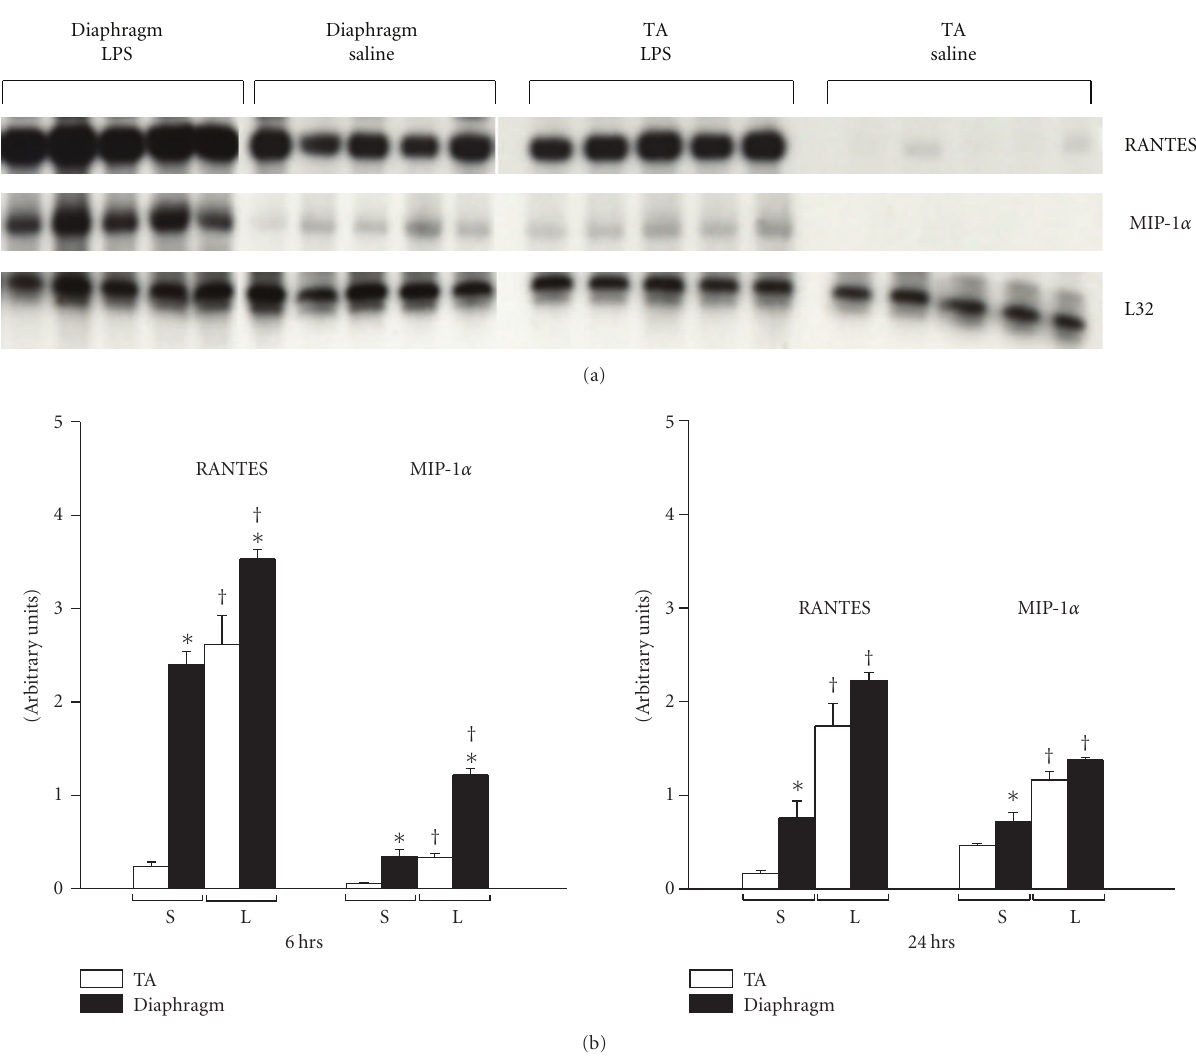
Figure 2: E ff ects of endotoxemia on RANTES and MIP-1 α gene expression in the diaphragm and limb muscle. (a) Ribonuclease protection assay demonstrating RANTES and MIP-1 α gene expression in the diaphragm and TA at 24 hours following LPS or saline administration. (b) Quantification of RANTES and MIP-1 α mRNA levels at di ff erent time points after LPS delivery. All data are group means ± SE, n = 6 mice per group. Data are normalized to the L32 housekeeping gene. ∗ P < . 05 for comparisons between diaphragm and TA within the same condition (LPS or sham control); † P < . 05 for comparisons between LPS- and sham control (saline)-treated mice within the same type of muscle (diaphragm or